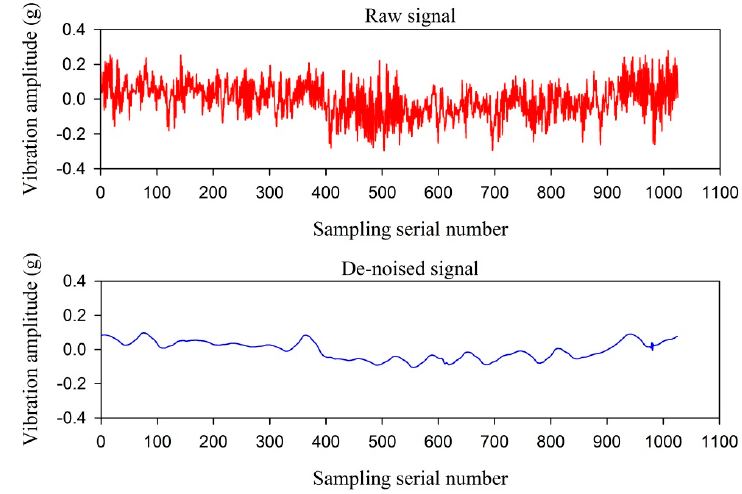
Figure 6. The raw vibration signal and the de-noised vibration signal.